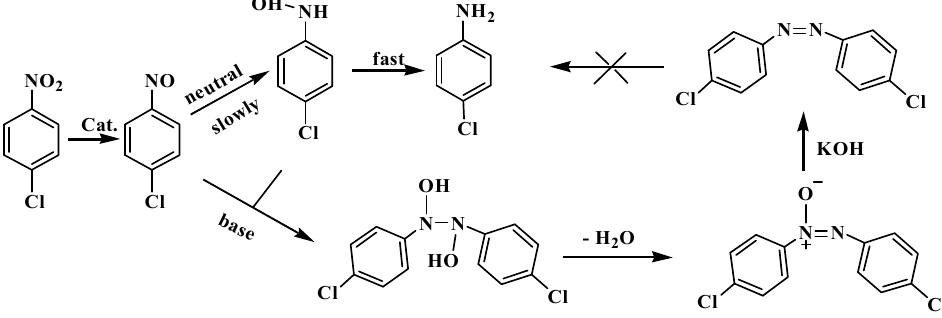
Figure 6. The mechanism of the hydrogenation of p -CNB to the corresponding DCAB.